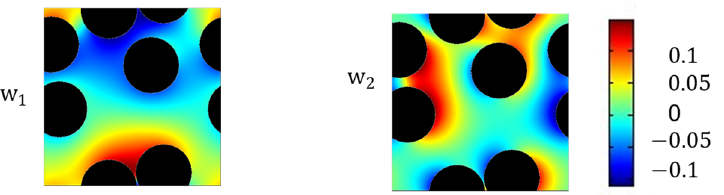
Figure 6. Base functions of diffusion in the RVE geometry with five fibers. w 1 is the base function of the y 1 -direction and w 2 to the y 2 -direction.